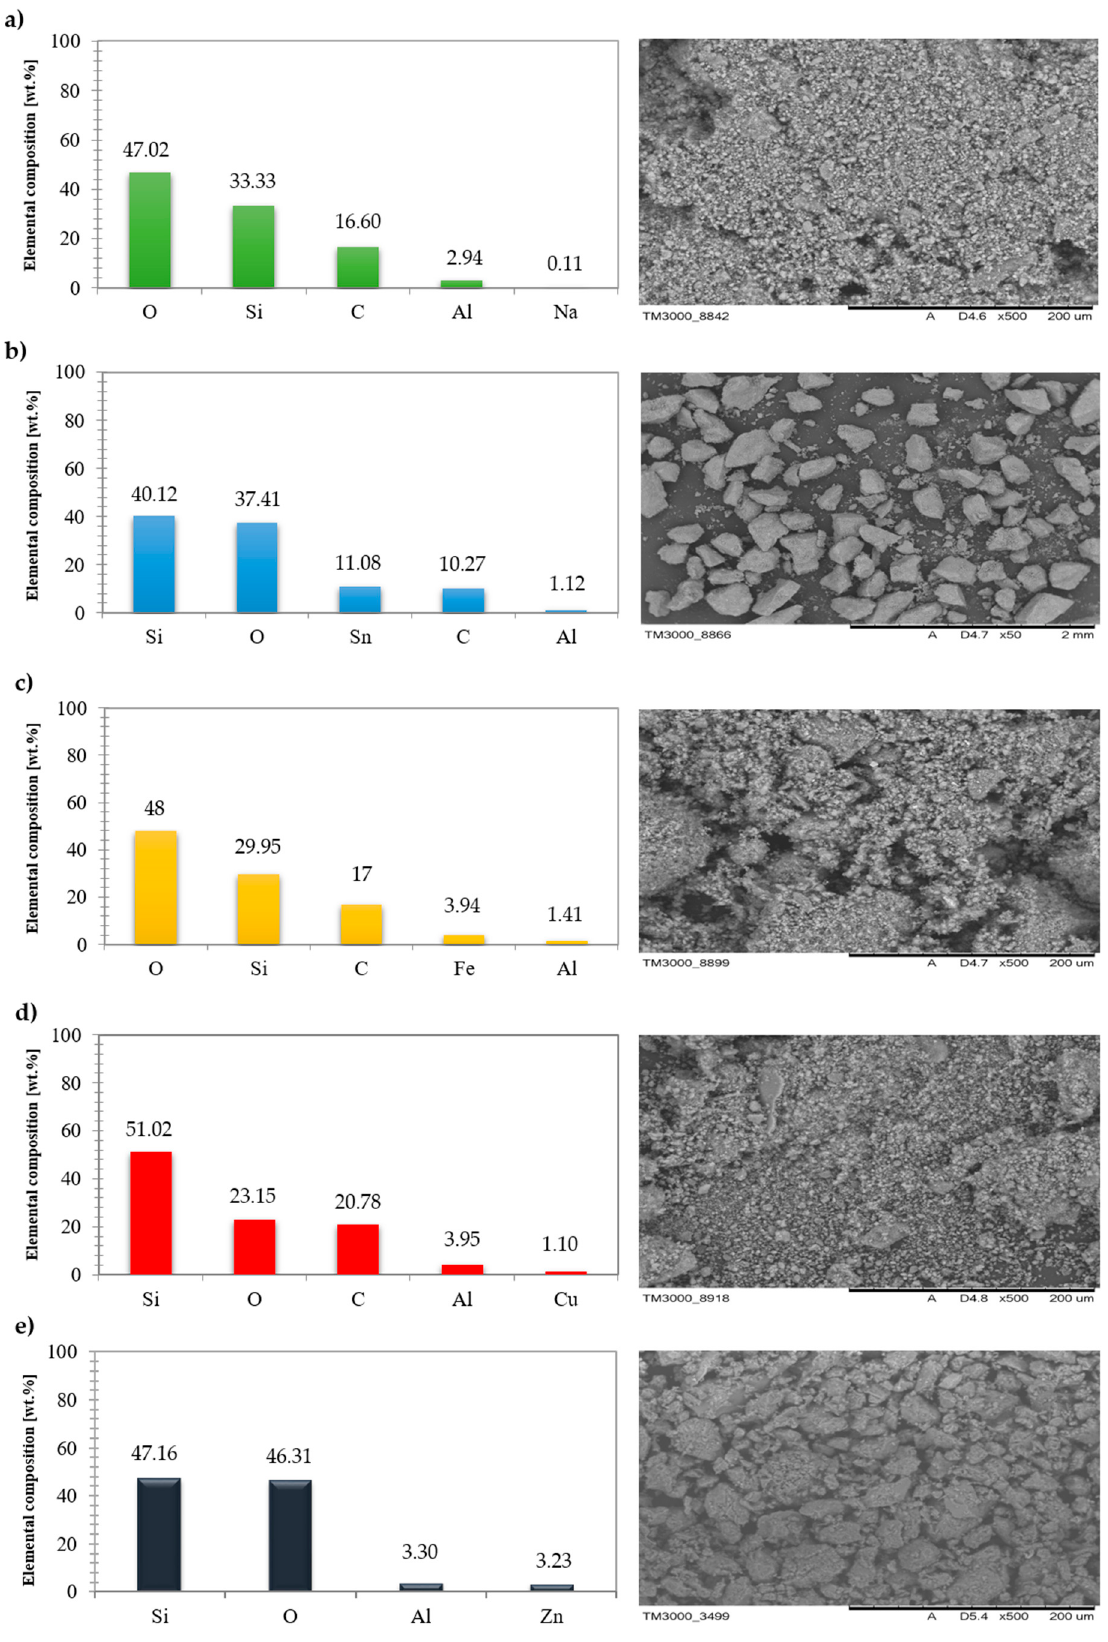
Figure 6. SEM and EDS for BEA zeolites with the metals ( a ) Na, ( b ) Sn, ( c ) Fe, ( d ) Cu and ( e ) Zn.